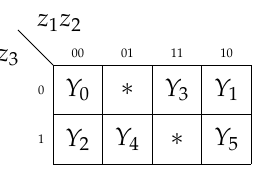
Figure 8. The outcome of encoding of COs for FSM S 1